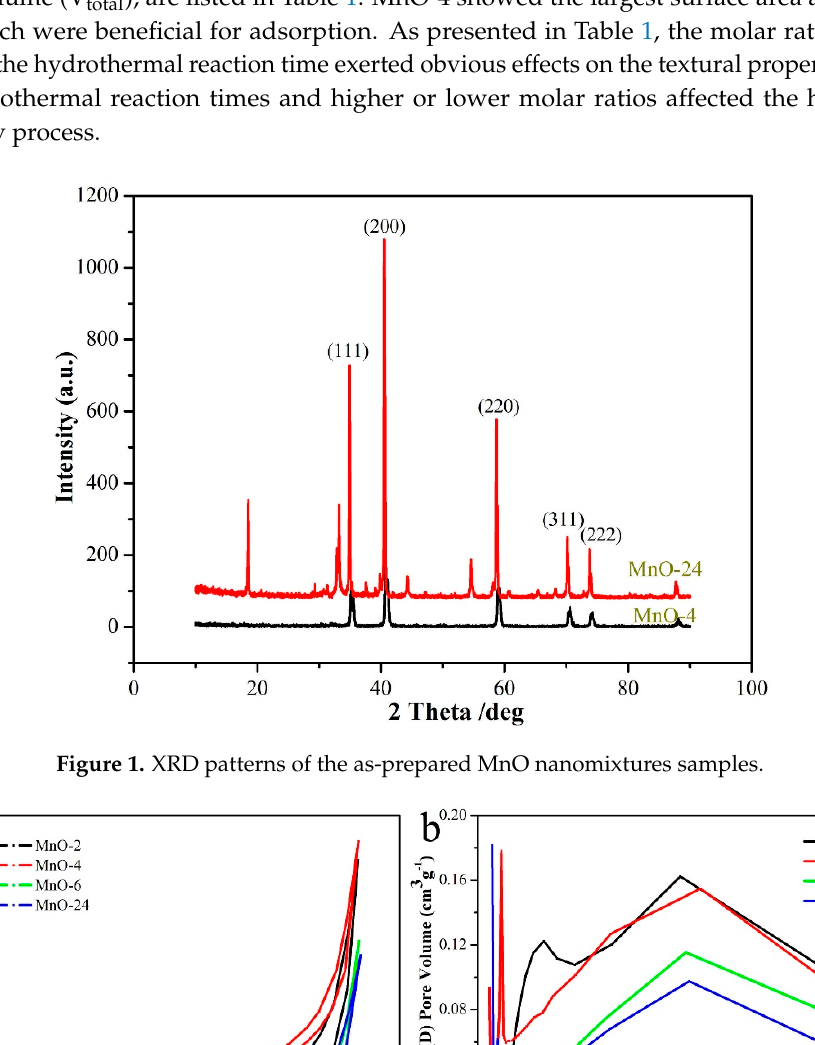
Figure 2. Nitrogen adsorption–desorption isotherms ( a ) and pore size distributions ( b ). Table 1. Surface characterization of different Table 1. Surface characterization of different samples.